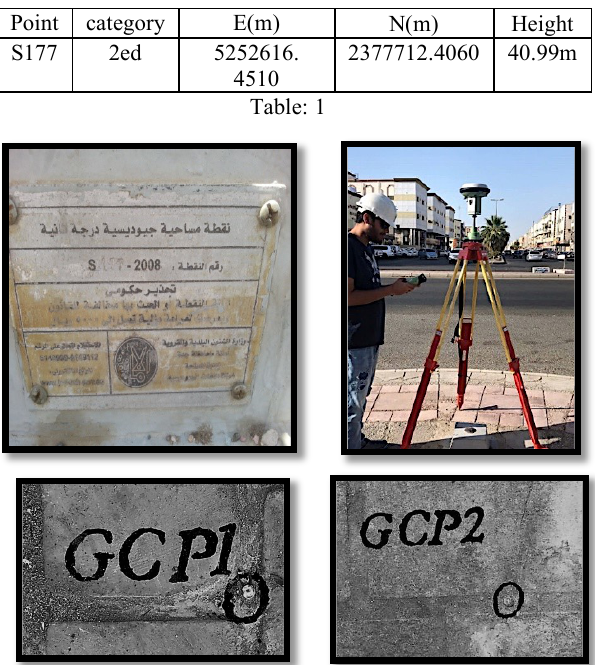
Figure 1: The process of identifying the